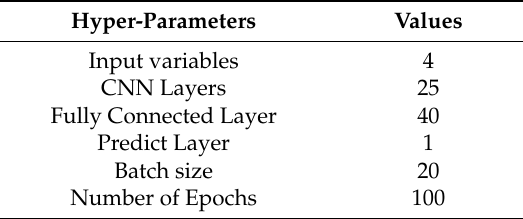
Figure 7. The fundamental structure of the CNN. Table 1. List of the values of hyper-parameters used in this network.